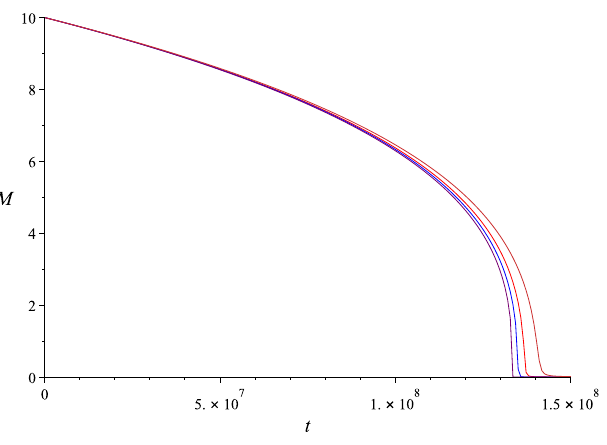
Figure 3 . Mass evolution of Schwarzschild black holes with negative GUP corrections. From right to left, the curves correspond to GUP parameters (cid:11) = (cid:0) 2 ; (cid:0) 1 ; (cid:0) 0 : 5 ; (cid:0) 0 : 1, respectively. Decreasing (cid:11) (i.e. more negative) has the e(cid:11)ect of pushing the curve towards the right. They all asymptote towards